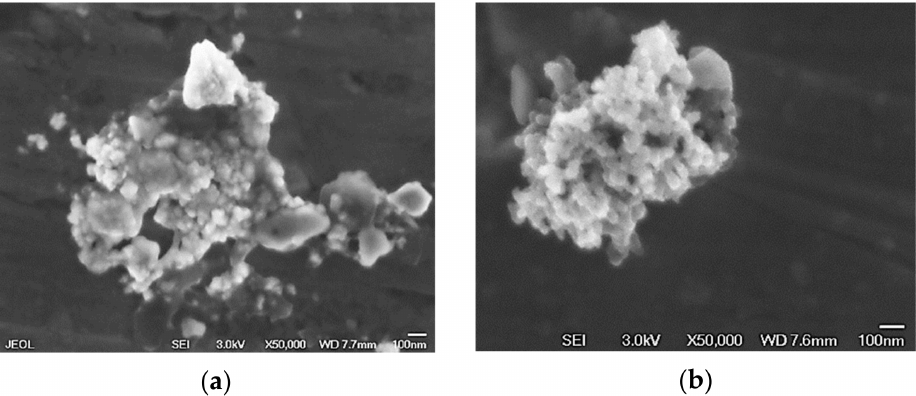
Figure 4. SEM micrographs of the imprinted polymers, ( a ) image at 50,000 × of MIP and ( b ) image at 50,000 × of IIP.